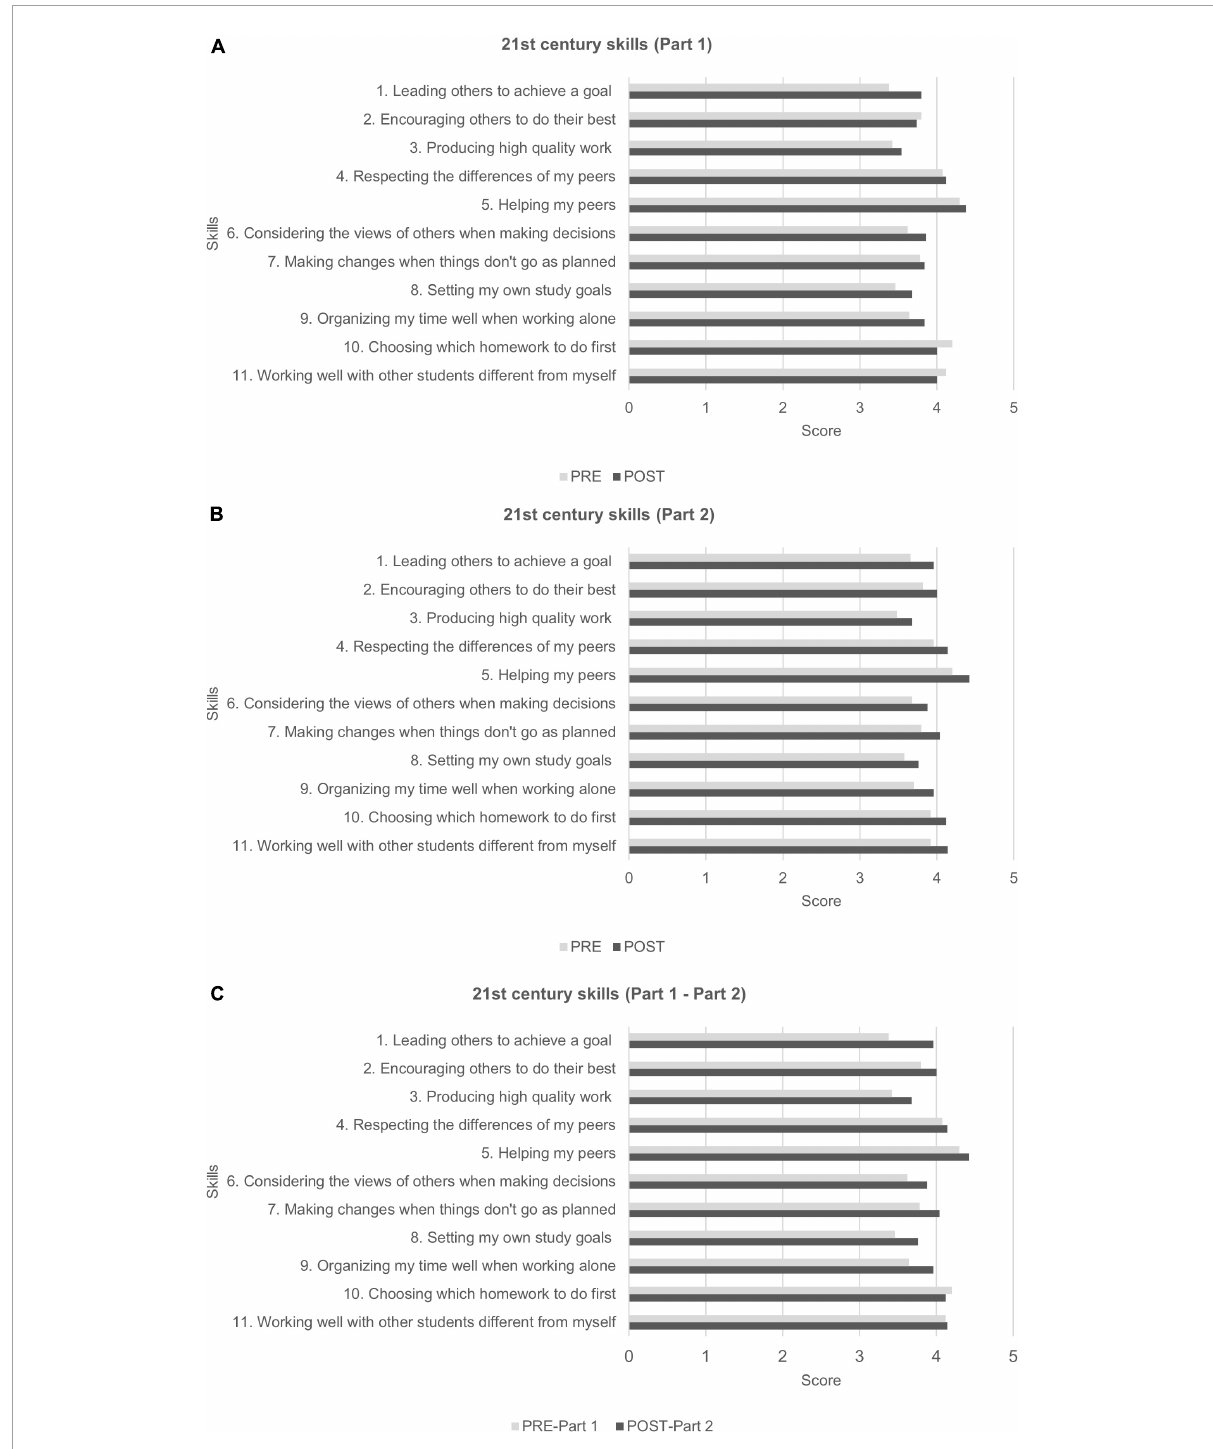
FIGURE1 Students’ attitude toward 21st century skills. (A) Histogram showing data from pre-post Part 1. (B) Histogram showing data from pre-post Part 2. (C) Histogram showing data from pre-Part 1 - post-Part